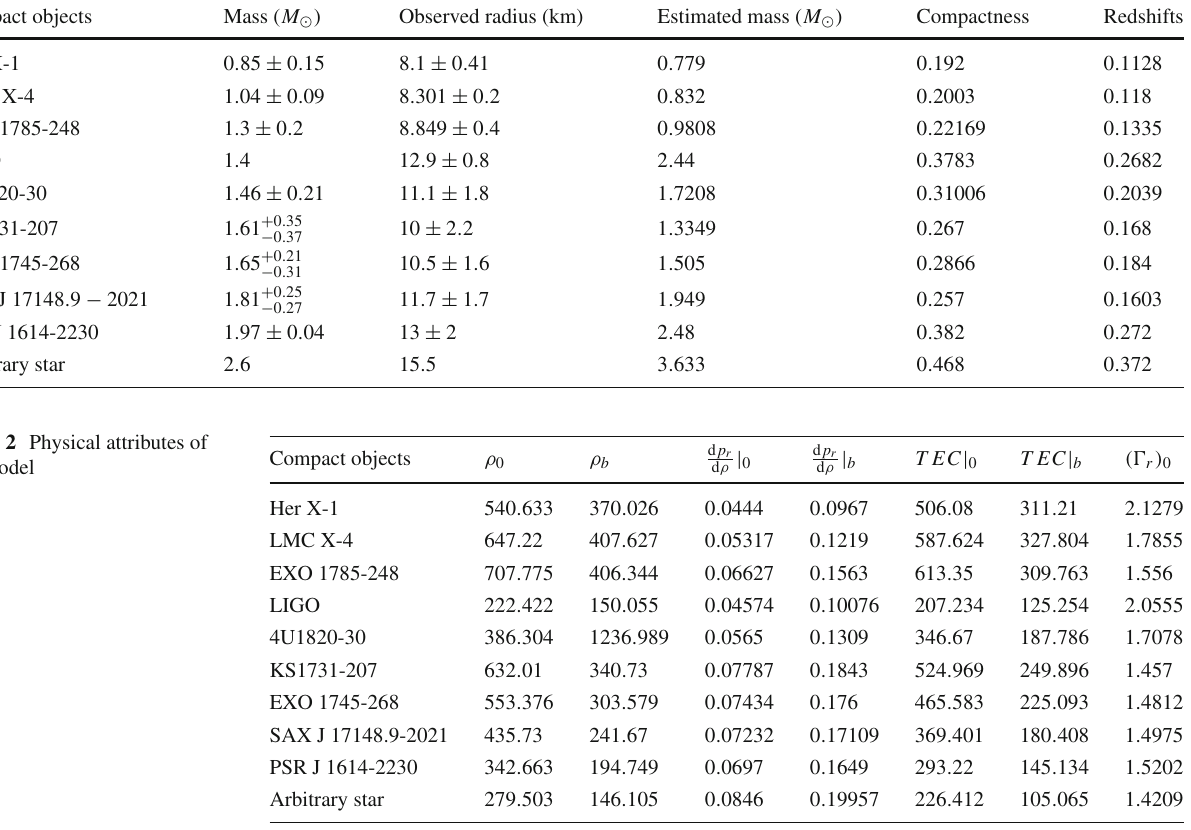
Table 1 Mass and radius of some known compact objects Compact objects